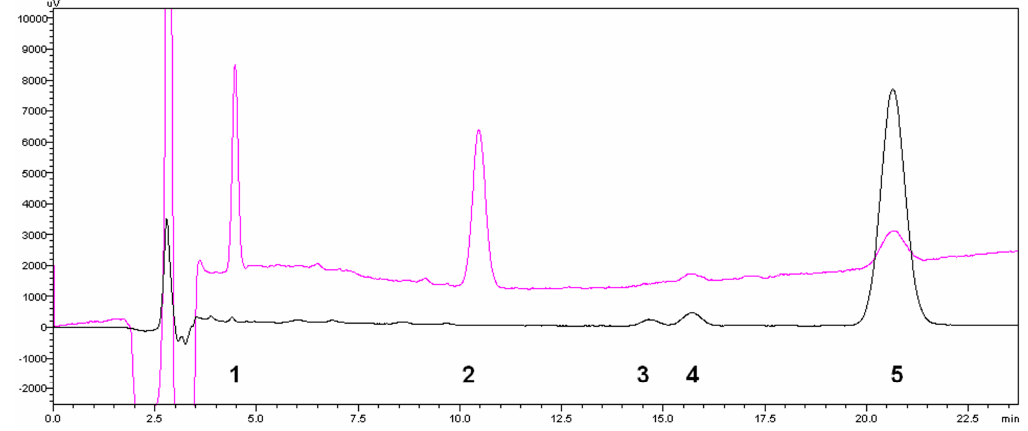
Figure 2. HPLC chromatography of SS-A ( 2 ) and its acid degradation products ( 1 , 3 , 4 , 5 ) under the detection wavelengths of 210 nm ( pink line ) and 254 nm ( black line ). Table 1. Degradation products of saikosaponin A formed in acid-forced degradation experiments.